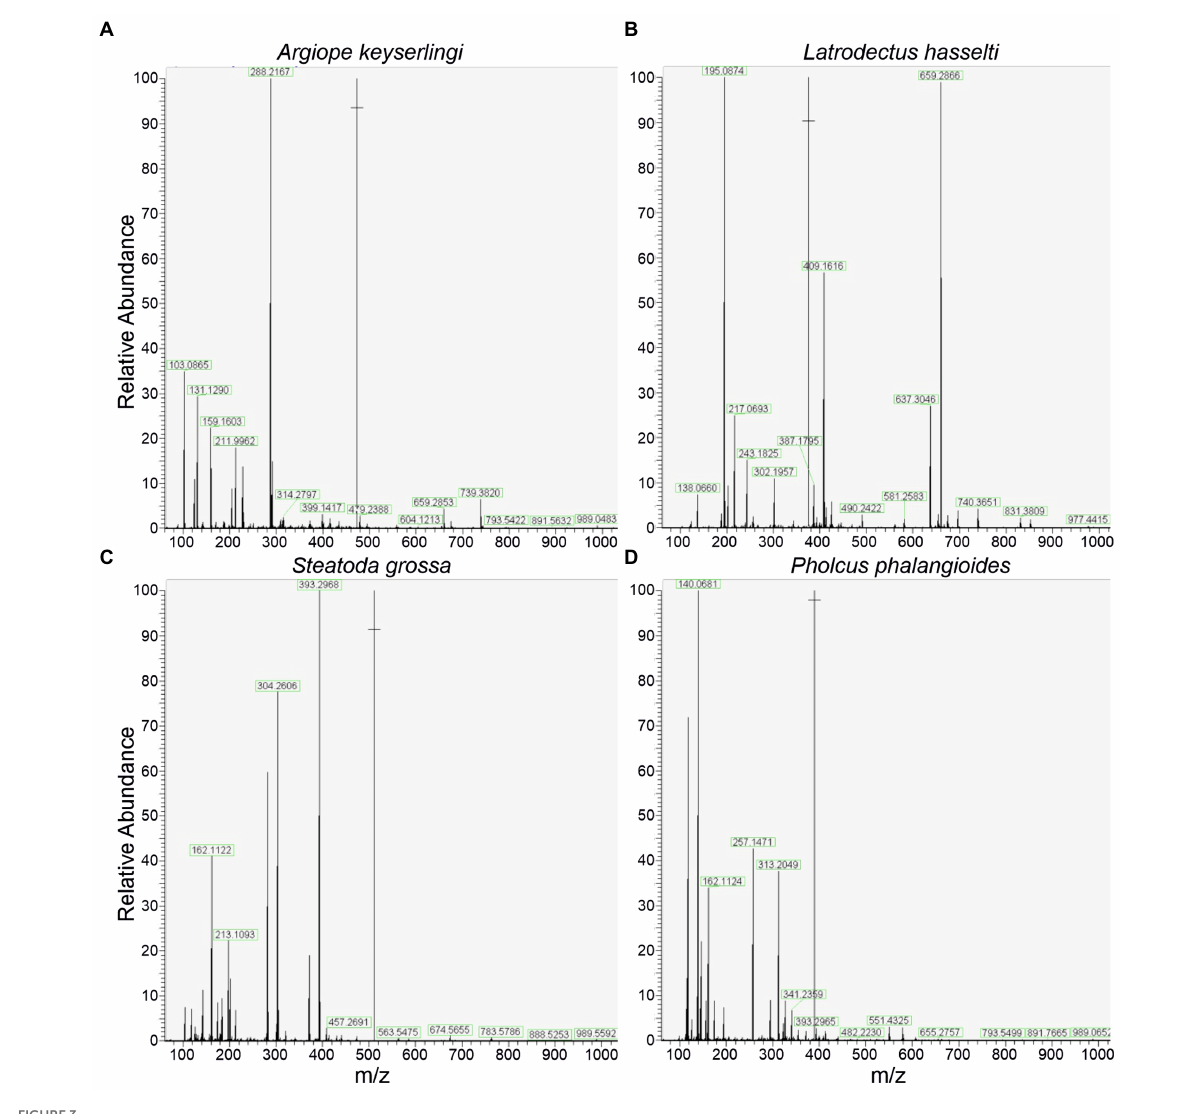
FIGURE 3 Spectral outputs for the tandem mass spectrometry (MS/MS) of the glues of Argiope keyserlingi (A) , Latrodectus hasselti (B) , Steatoda grossa (C) , and Pholcus phalangiodes (D)